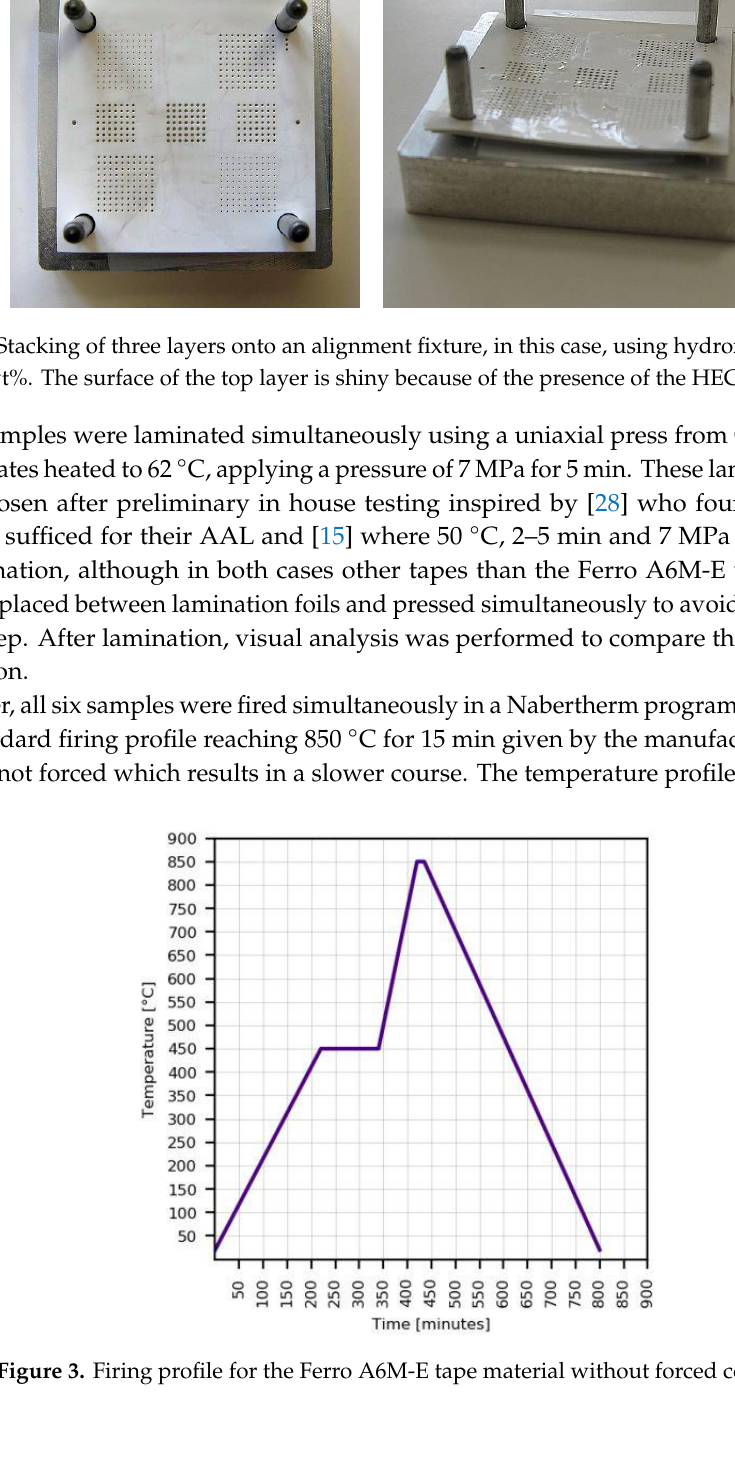
Figure 3. Firing profile for the Ferro A6M-E tape material without forced cooling.